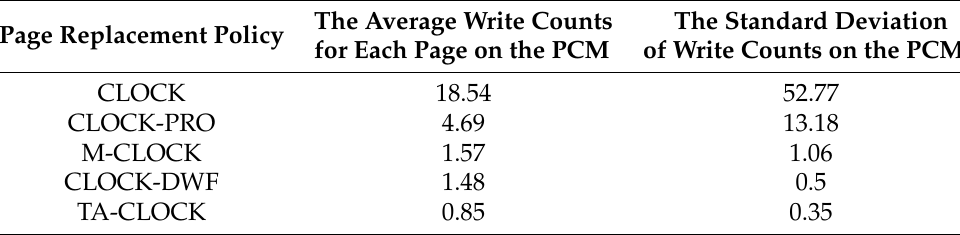
Figure 7. Distribution of write counts in the PCM. Table 7. The average and standard deviation of write counts in PCM